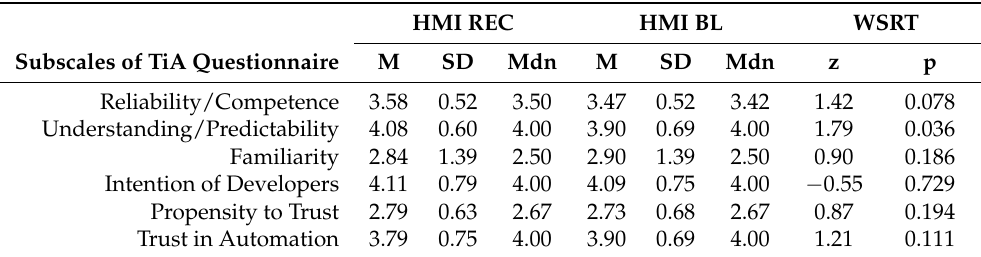
Table 4. Scores of the TiA questionnaire with answers in each subscale ranging from (1) strongly disagree to (5) strongly agree. Wilcoxon Signed Rank Test is abbreviated as WSRT.